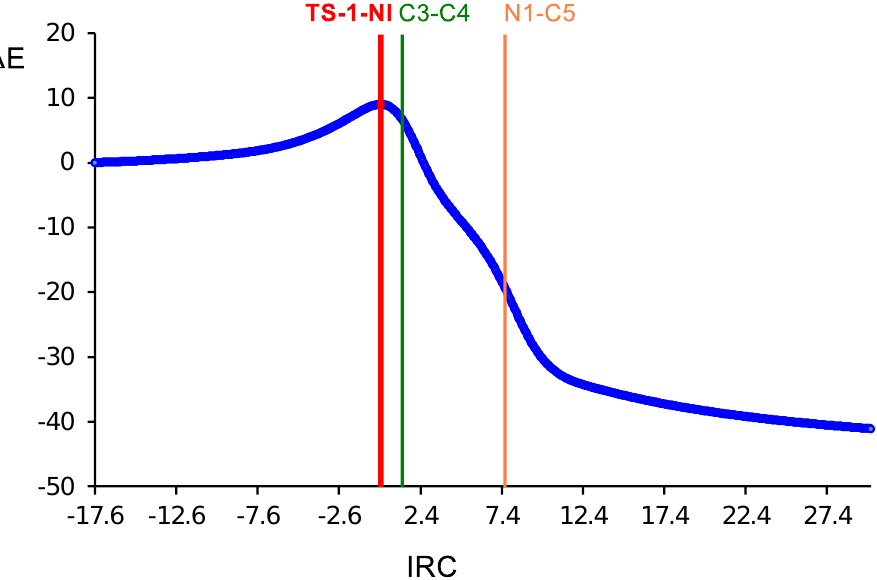
Figure 5. Gas-phase B3LYP / 6-31G(d) IRC associated with the 32CA reaction between diphenyl NI 2a and (R)-carvone 1 . The red line indicates the position of TS-1-NI , the green line indicates the position of the formation of the first C3 − C4 single bond, and the orange line indicates the position of the formation of the second N1 − C5 single bond. Relative energies ( ∆ E, in kcal · moL − 1 ) are given with respect to the first structure of the reaction path, S1-1-NI .